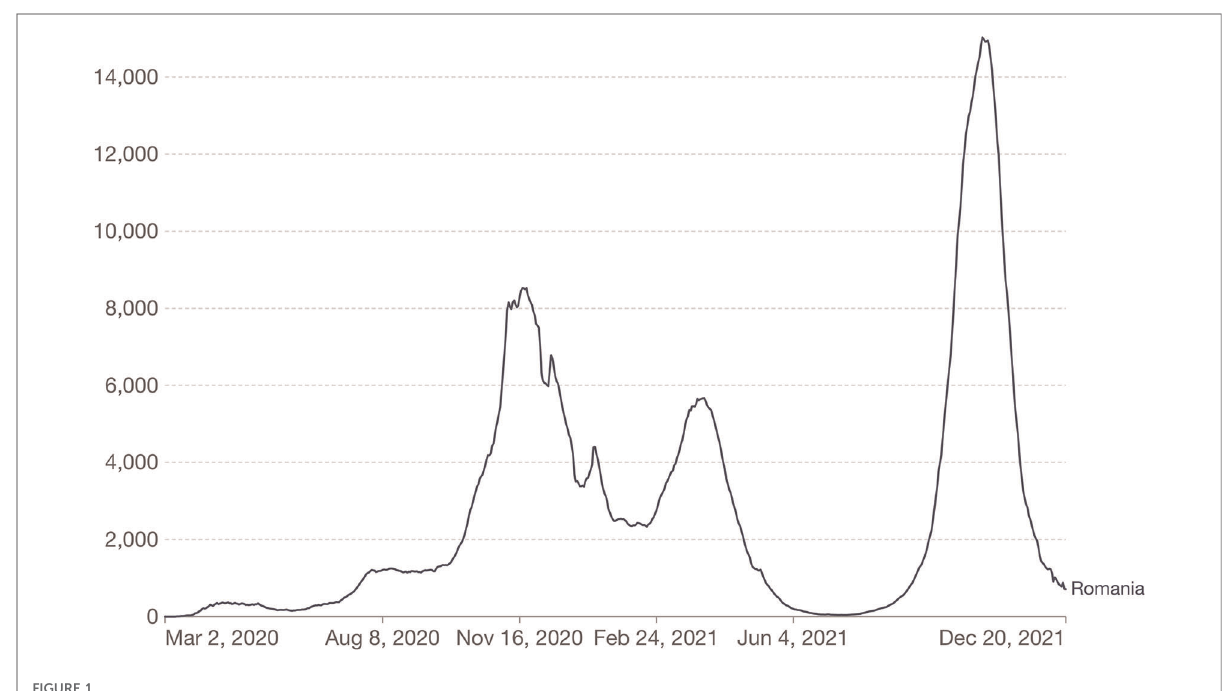
FIGURE 1 Evolution of the number of patients newly diagnosed with COVID-19 in Romania